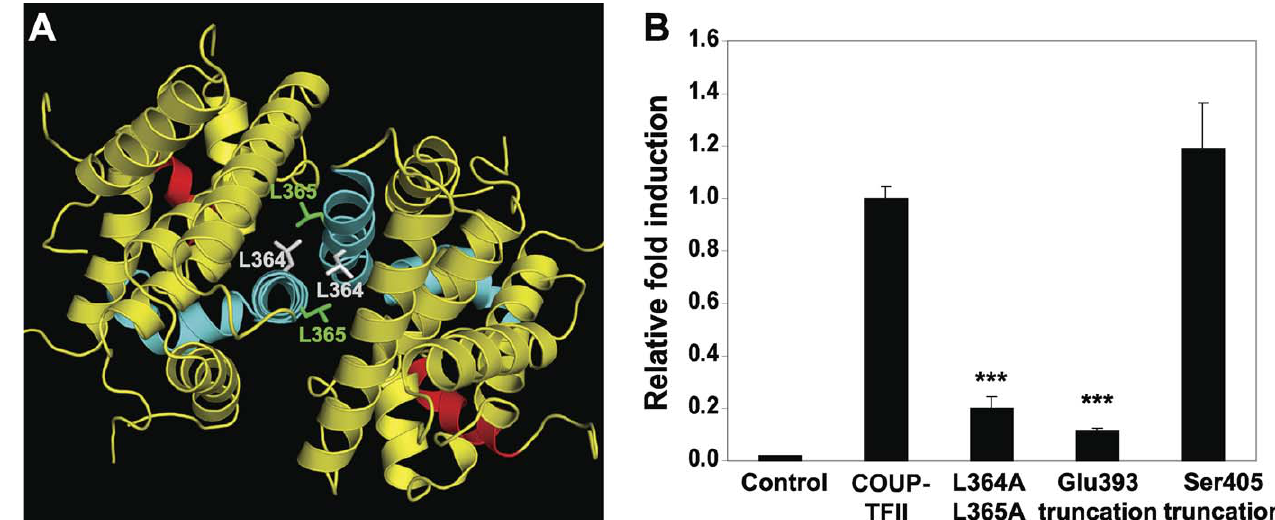
Figure 3. COUP-TFII Activation Is Dependent on the Formation of a Functional Dimer and the Presence of AF2 (A) Top view of the COUP-TFII dimer showing the close packing of L364 (gray) and L365 (green) from helices a 10 (cyan) in the dimer interface. (B) Effects of the L364A/L365A double mutant and the AF2 deletion mutant on COUP-TFII activation of the NGFI-A promoter. For easy comparison, the relative fold of activation by the wild-type receptor is set to 1. The statistical analysis for the fold induction of the mutants was compared with wild type